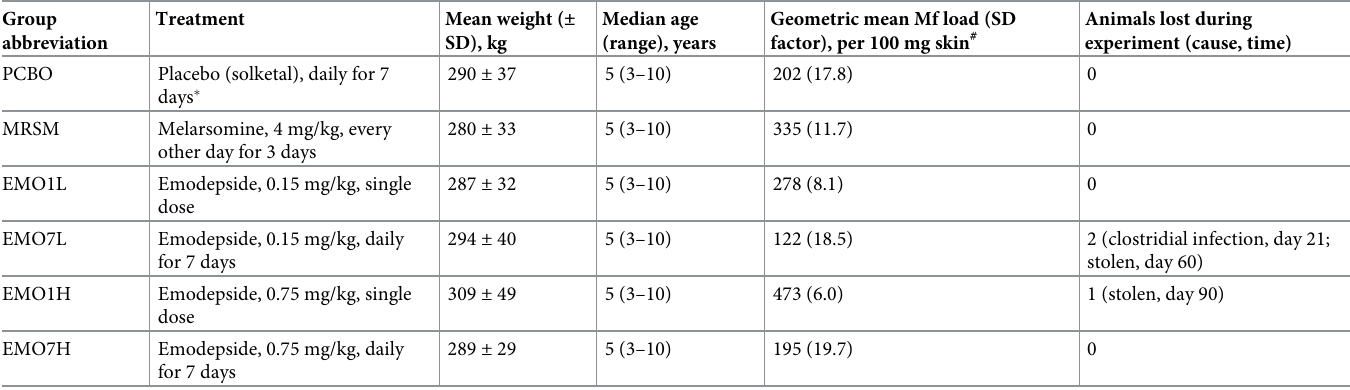
Table 1. Characteristics of the treatment groups in